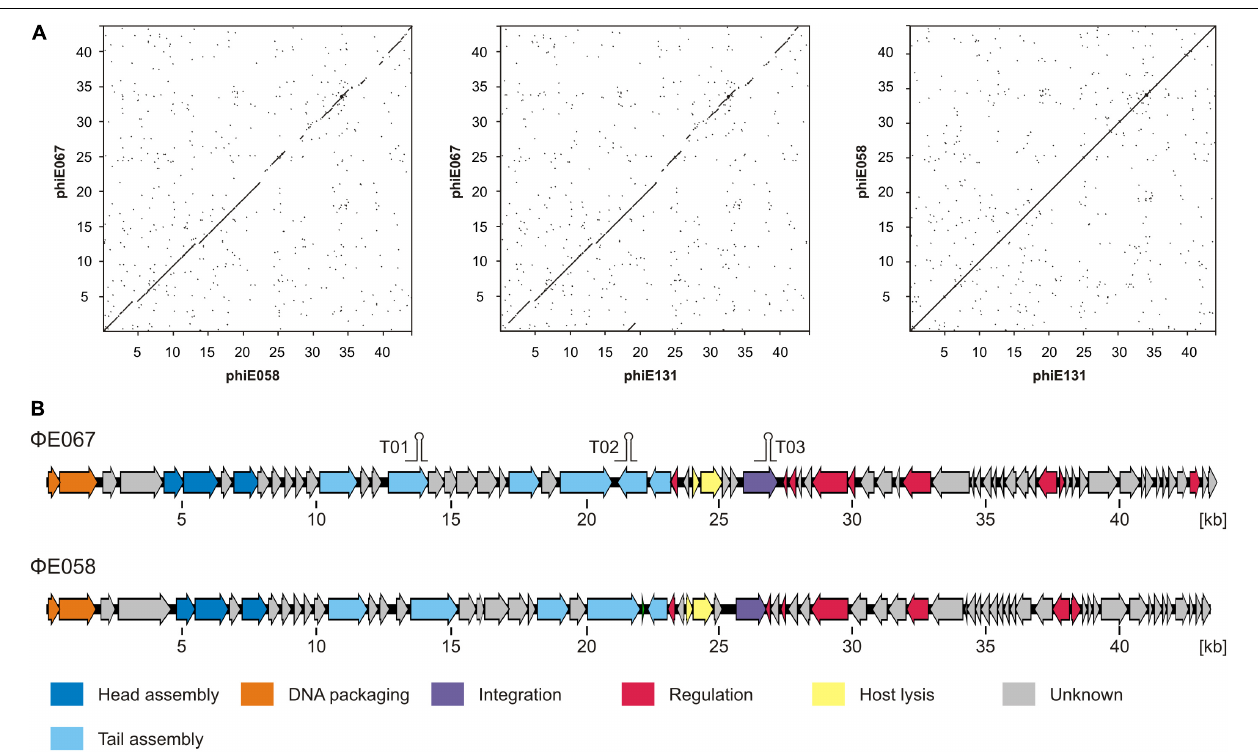
FIGURE 3 | (cid:56) E067 and (cid:56) E058/ (cid:56) E131 are closely related phages. (A) Dot plot alignments of the phages. (B) Genome organization of (cid:56) E067 and (cid:56)